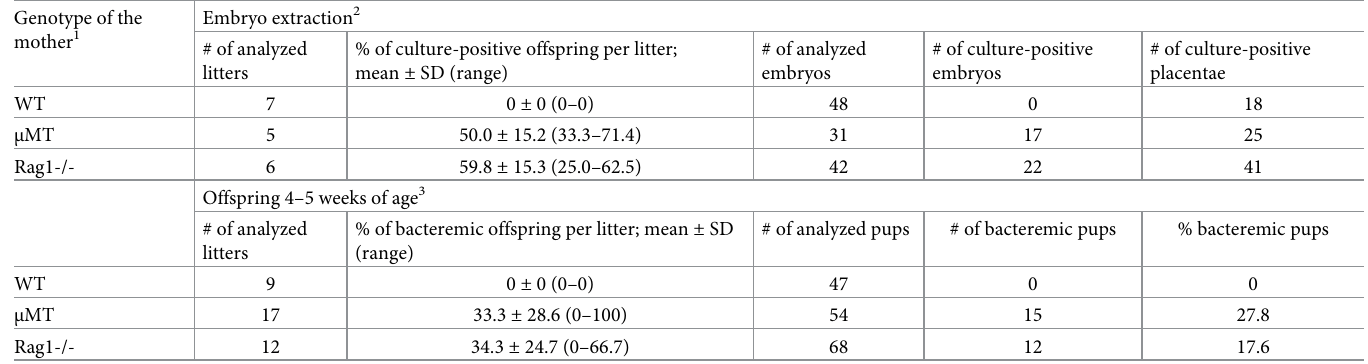
Table 1. Transplacental transmission of B . taylorii in B cell-deficient, but not wildtype mice. Genotype of the mother